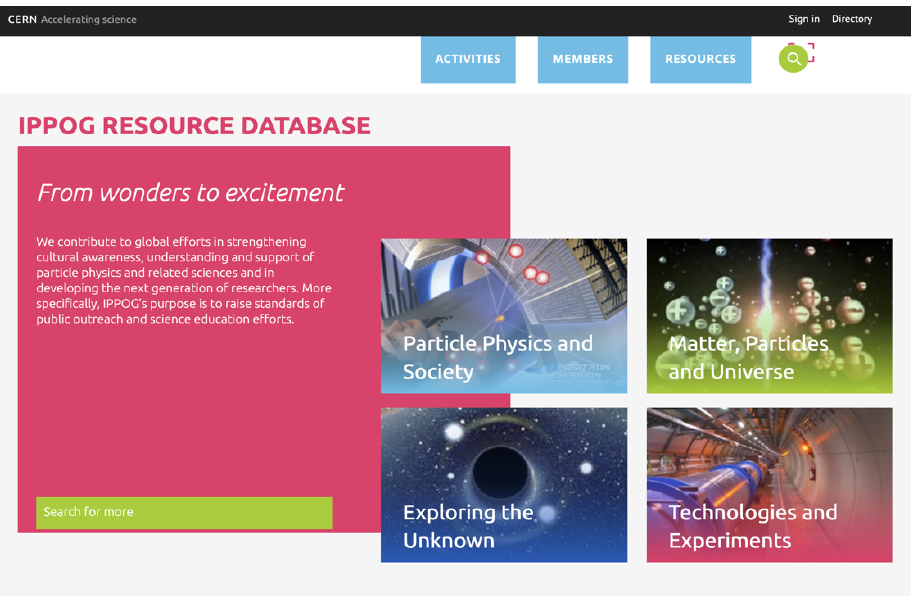
Figure 2 . New IPPOG Resource Database design, proposed in